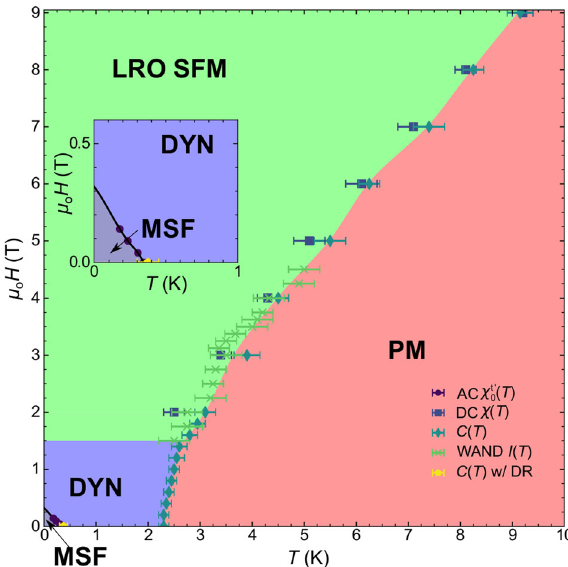
Fig. 5 Phase diagram of Yb 2 GaSbO 7 as determined by magnetic susceptibility, heat capacity, and neutron scattering measure- ments. Shaded regions include a paramagnet (PM), an XY splayed ferromagnet (LRO SFM), a correlated, dynamic phase (DYN) and a regime with minority spin freezing (MSF). The inset depicts an enlarged version of the low-temperature, low- fi eld portion of the phase diagram. The points on the phase diagram were derived from fi tting the relevant features of the respective datasets to simple functions, and the error bars for the points correspond to the standard errors from these fi